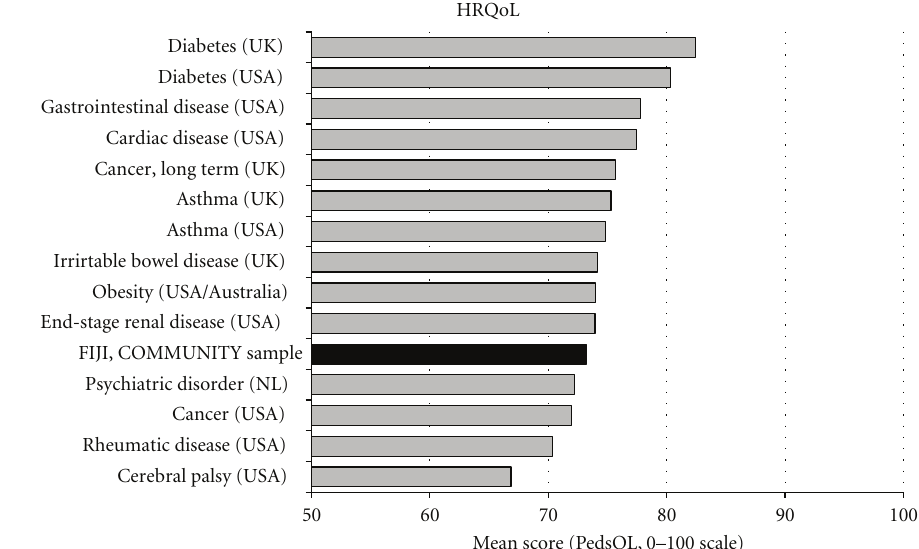
Figure 2: Comparison between self-rated health-related quality of life (HRQoL) in a community sample of school-aged children in Fiji and HRQoL in school-aged patients with specific diagnoses in USA, Australia, UK, and the Netherlands (NL). HRQoL is measured by the PedsQL in all samples. Adapted from [16,